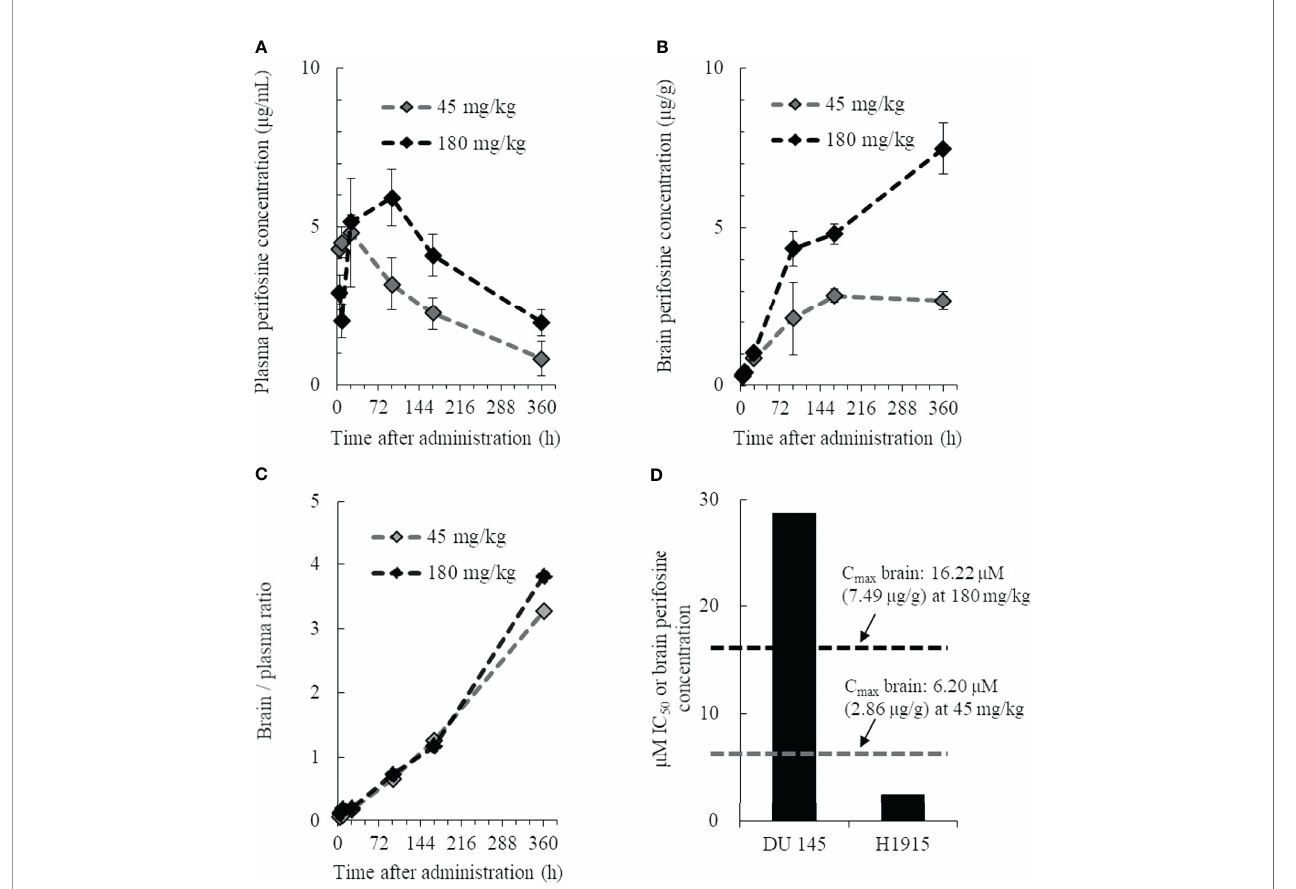
FIGURE 1 | Pharmacokinetic pro fi le of perifosine in plasma and brain tissue. Healthy animals were administered a single oral dose of perifosine, and at six intervals, mice from each group were then euthanized for plasma (A) and brain (B) extraction (n = 3). (C) The brain-to-plasma ratio of perifosine was calculated at each time point. (D) Relationship between the brain C max and in vitro IC 50 for DU 145 and H1915